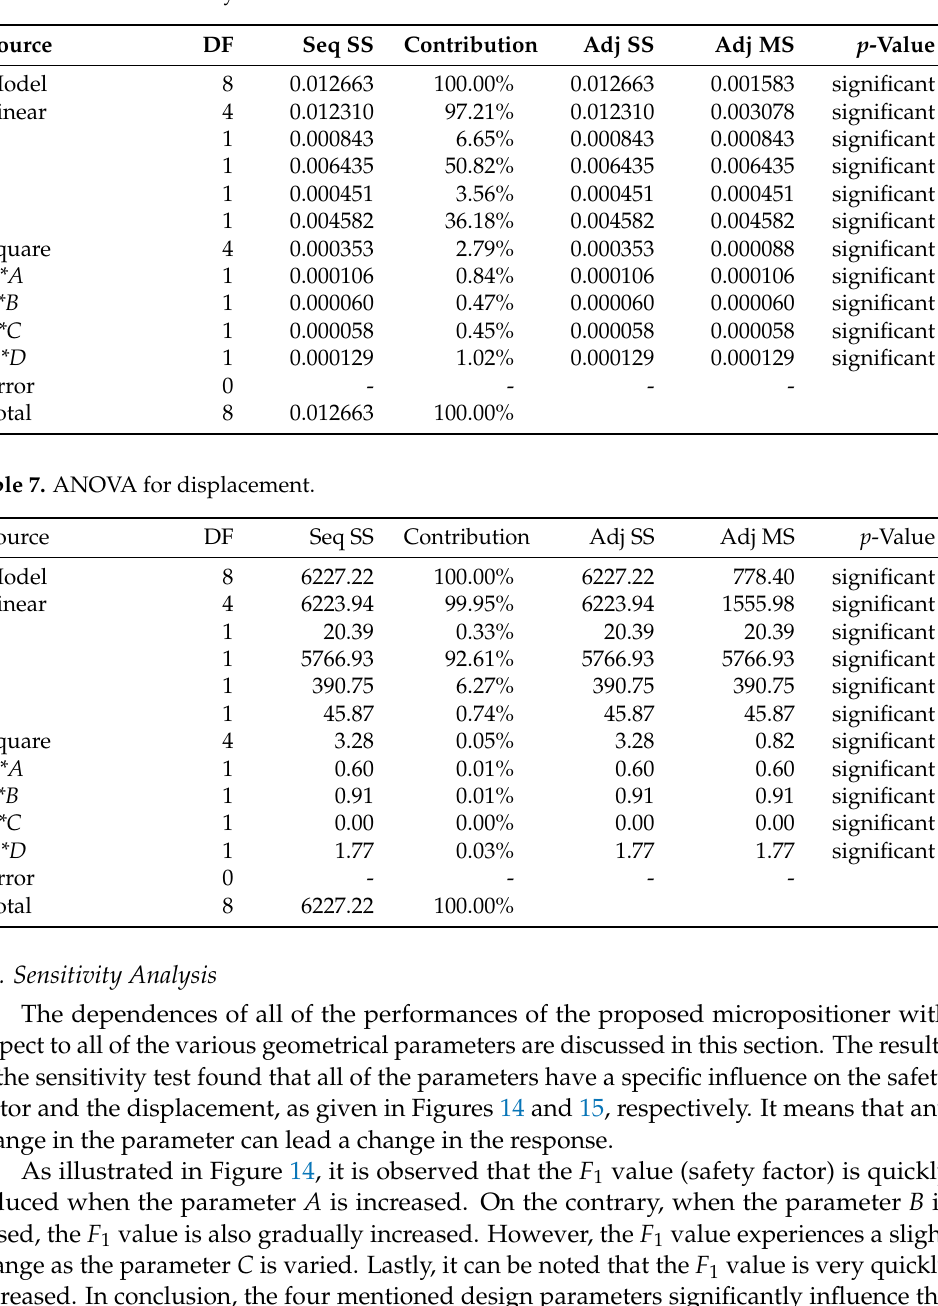
Table 6. ANOVA for safety factor.